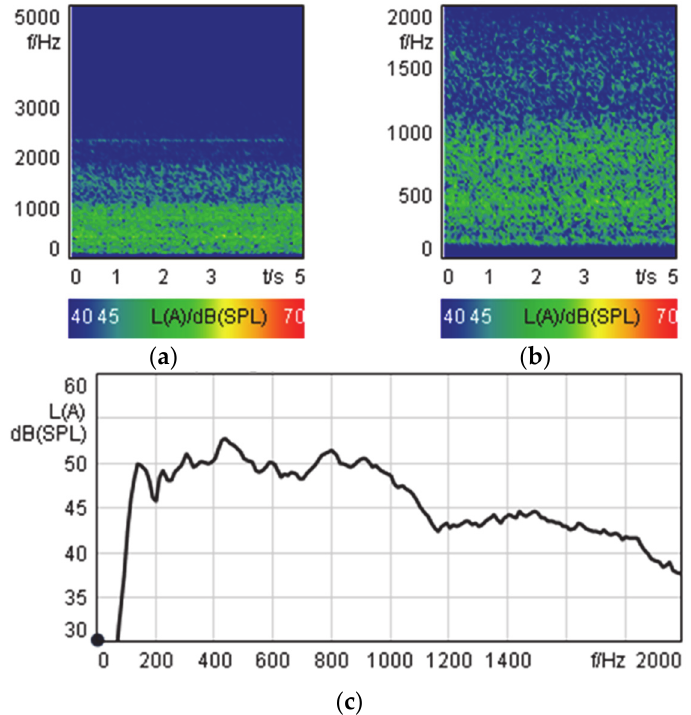
Figure 2. HVAC system noise measurement results when 13 V voltage is applied: ( a ) 0–5000 Hz range colormap; ( b ) 0–2000 Hz range colormap; and ( c ) 0–2000 Hz range SPL.